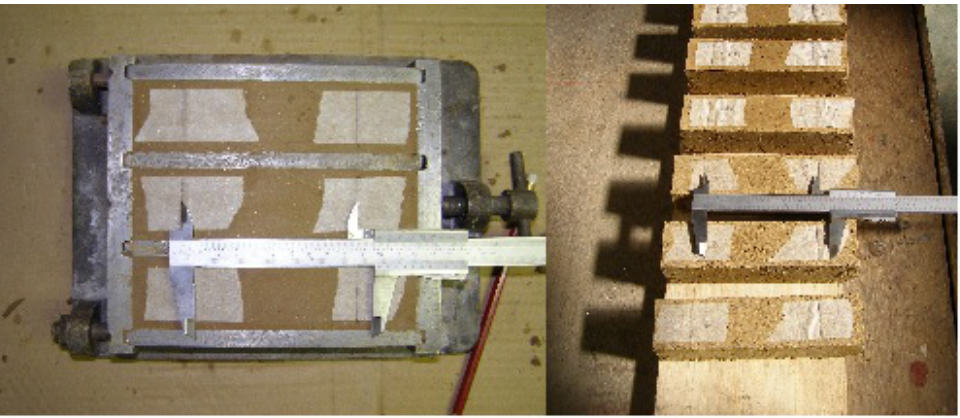
Figure 4. Test of